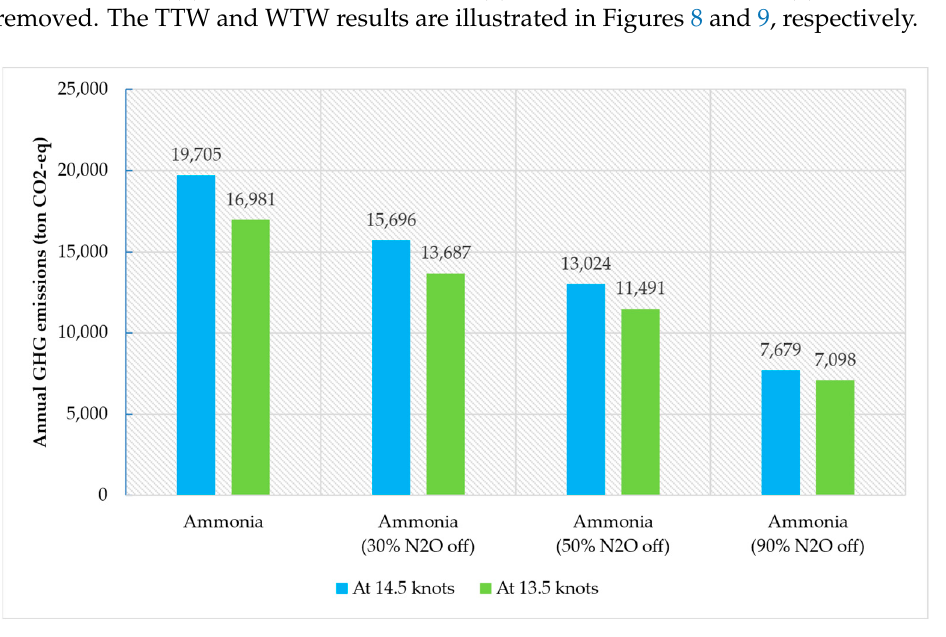
Figure 9. Comparison of annual WTW GHG emissions considering N 2 O abatements of using am- monia. The calculation sheet considering N 2 O abatements can be found in Table S2 and S3 in the Supplemental Material available online.